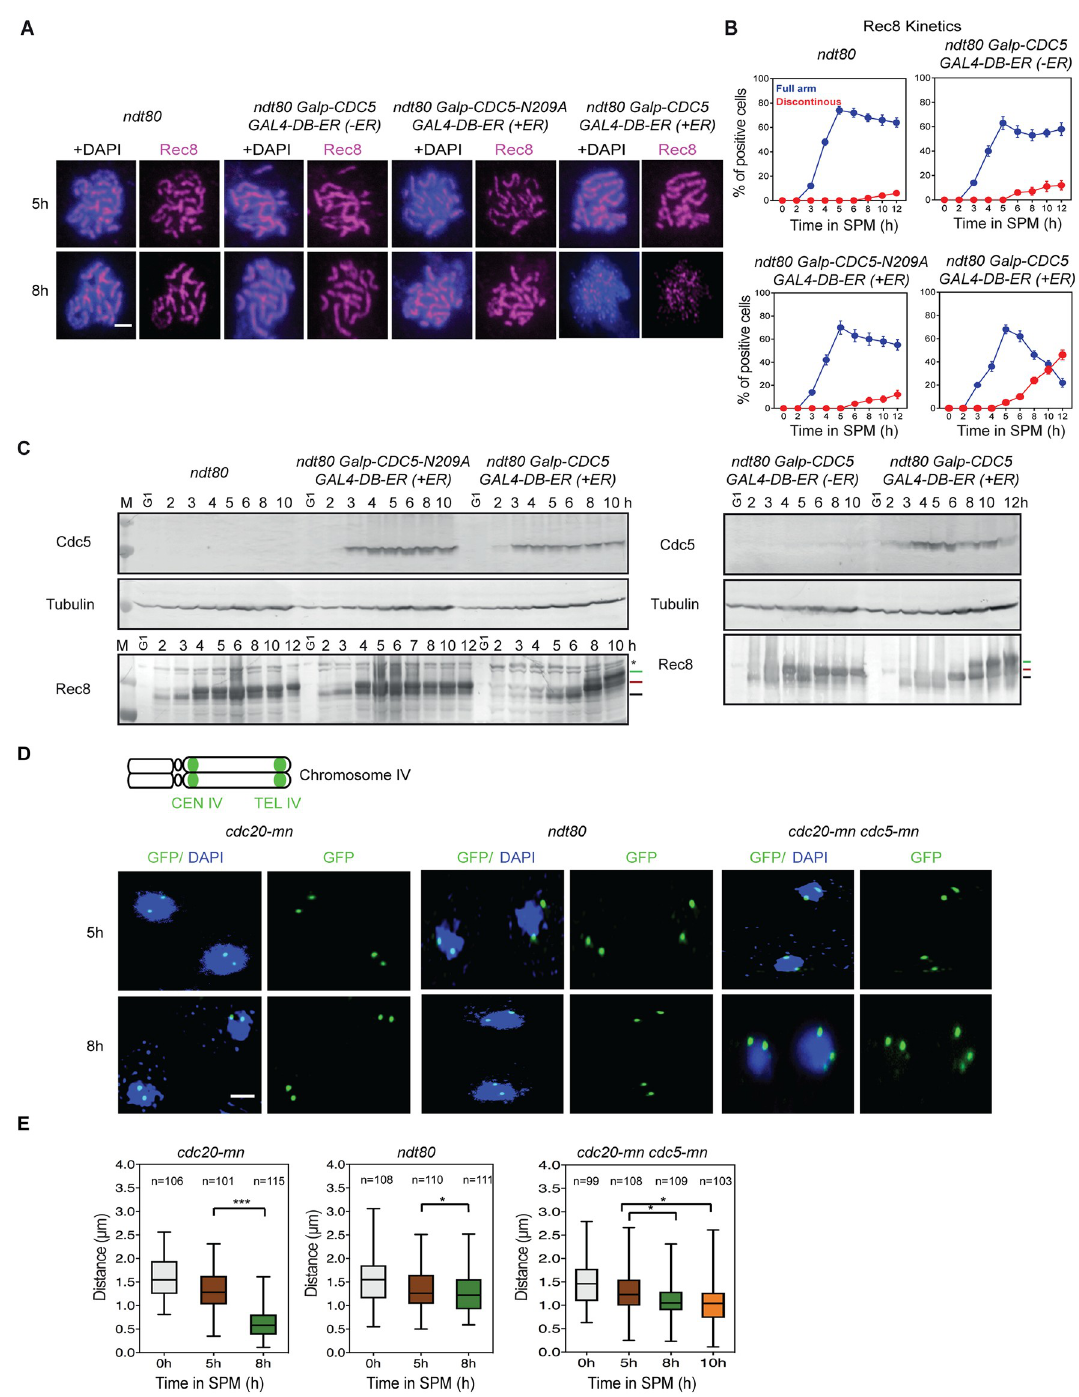
Fig 5. Cdc5 is sufficient for cleavage-independent Rec8 dissociation from meiotic chromosomes. (A) Localization of Rec8 (red) with or without DAPI (blue) in ndt80 (KSY467/468), ndt80 GALp-CDC5 GAL4-DB-ER without estradiol induction (-ER) (KSY887/ 888), ndt80 GALp-CDC5-N209A GAL4-DB-ER with estradiol induction (+ER) (KSY882/883) and ndt80 GALp-CDC5 GAL4-DB-ER (-ER) (KSY887/888) cells is shown. CDC5 overexpression was induced by the addition of 400 nM Estradiol at 2 h. (B) Kinetics of Rec8 classes in (A) was classified shown in Fig 1B. A minimum 100 cells were counted at each time point. (C) Expression profiles of Cdc5 during meiosis were verified by western blotting in ndt80 (KSY467/468), ndt80 GALp-CDC5 GAL4-DB-ER without estradiol induction (-ER) (KSY887/888), ndt80 GALp-CDC5-N209A GAL4-DB-ER with estradiol induction (+ER) (KSY882/883) and ndt80 GALp-CDC5 GAL4-DB-ER (-ER) (KSY887/888) cells is shown. CDC5 overexpression was induced by the addition of 400 nM Estradiol at 2 h.